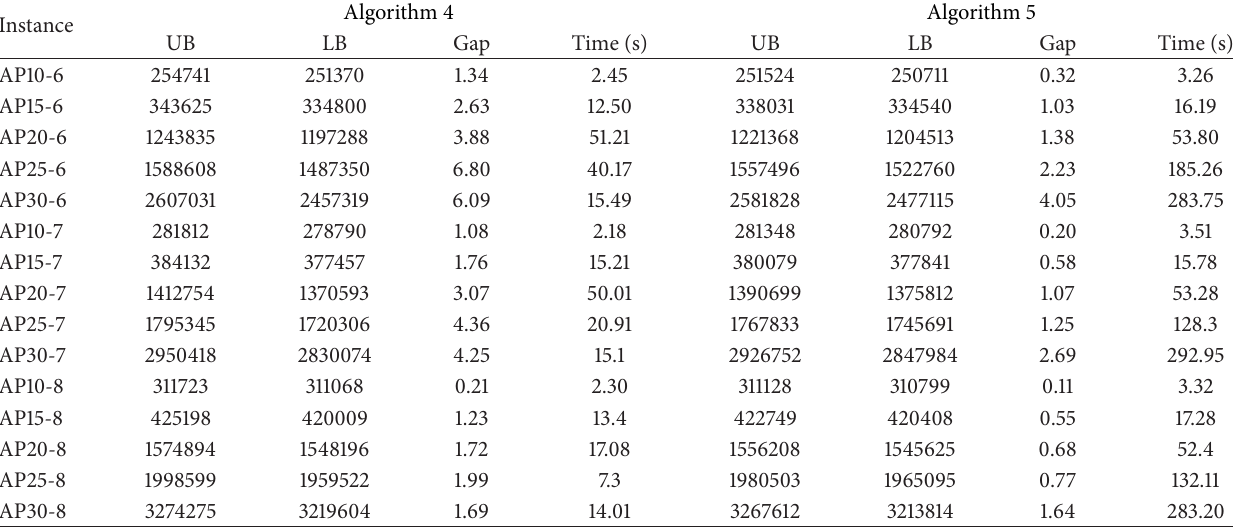
Table 2: Computational result of Algorithms 4 and 5 for AP data